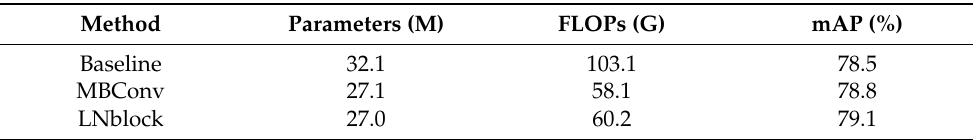
Table 6. Ablation study results of StdConv, MBConv, and LNblock for the PASCAL VOC 2007 test dataset.